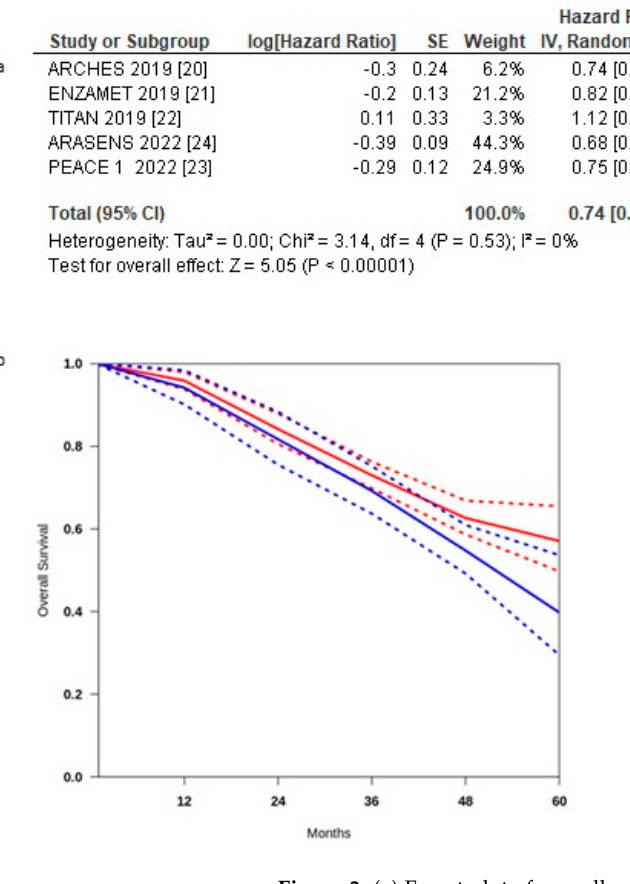
Figure 3. ( a ) Forest plot of overall survival hazard ratios obtained using a random model. Studies are arranged by publication year. ( b ) Curves of overall survival obtained using the approach of Combescure et al. with random effects. Blue lines represent the summarized disease progression curves and the 95% confidence bands (dashed lines) for control arm. Red lines represent the summarized disease progression curves and the 95% confidence bands (dashed lines) for triplet treatment.